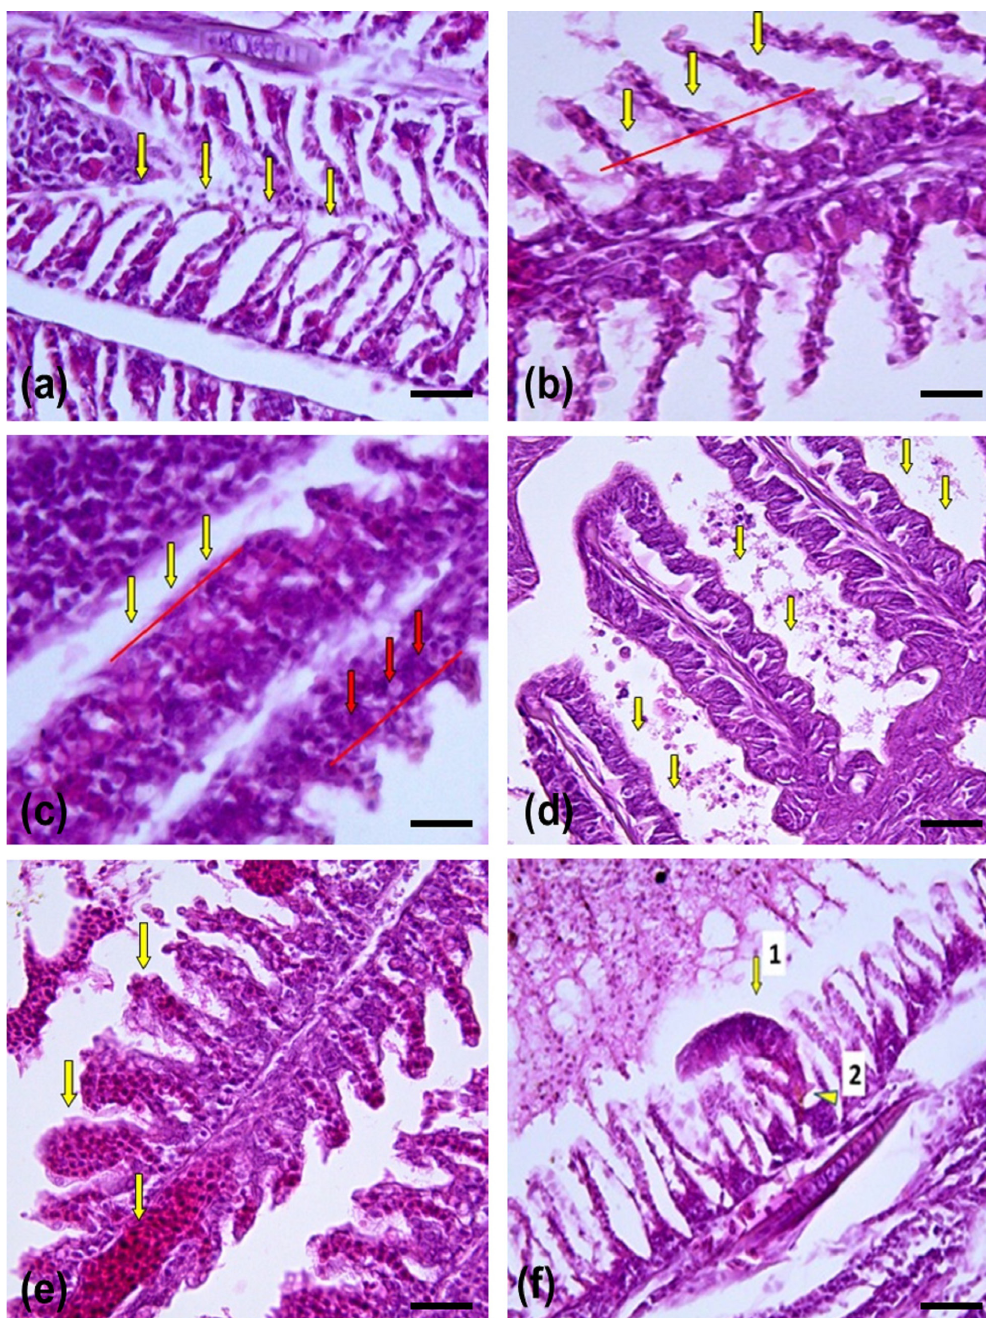
Figure 1 - Longitudinal section of gills of juvenile mullet Mugil liza with histological alterations caused by infestation of Ligophorus uruguayense . ( a ) respiratory epithelium detachment (yellow arrow). ( b ) mild hyperplasia (yellow arrow). Red line shows that hyperplasia affects less than half of the gill filament length. ( c ) moderate hyperplasia (red arrow). Red line shows hyperplasia affects half the length of the filament. Severe hyperplasia (yellow arrow). Red line shows that hyperplasia affects all the gill filament length. ( d ) necrosis of the respiratory epithelium (yellow arrow). ( e ) telangectasia (yellow arrow). ( f .1) Ligophorus uruguayensis fixed on the gill filament (yellow arrow). ( f .2) Haptor (yellow arrow). (n = twenty fish). All hematoxylin eosin staining, Scale bar = 200